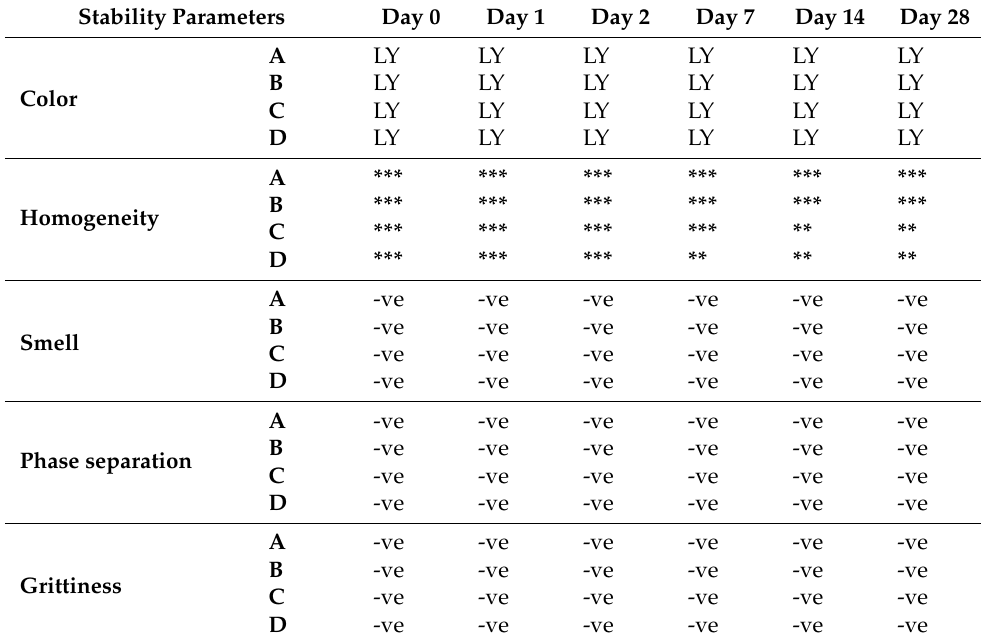
Table 1. Physical parameters of naproxen-eugenol emulgel in different storage conditions. Stability Parameters